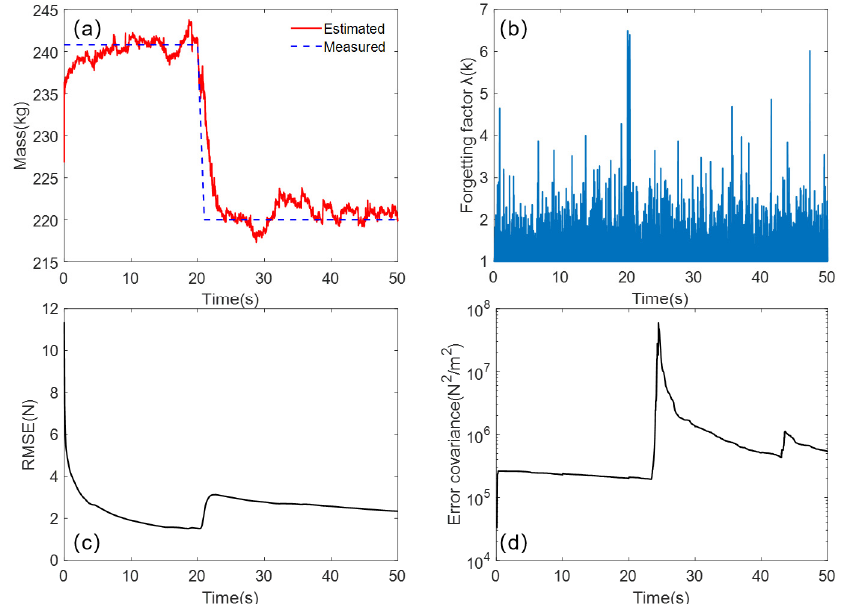
Figure 12. Experimental results of vehicle mass estimation; ( a ) estimated vehicle mass (240 kg → 220 kg from 20 to 21 s), ( b ) time evolution of the forgetting factor, ( c ) RMSE, and ( d ) convergence history of error covariance.